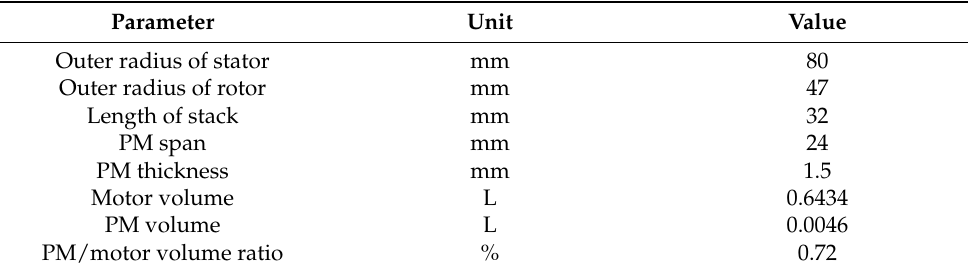
Figure 1. Rotor layouts of investigated models. Table 1. Specifications of Target Motors.